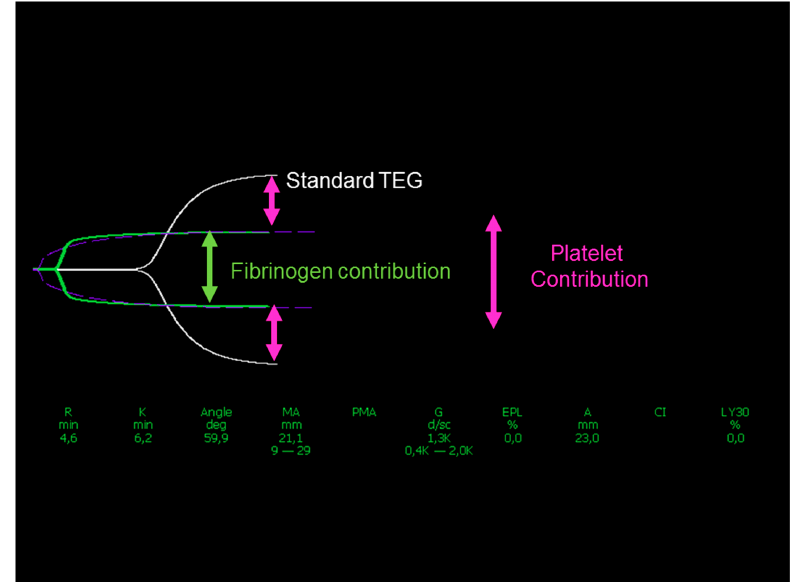
Figure 2. Platelet contribution to clot strength as the difference between amplitudes in standard thromboelastography (TEG, white trace) and fibrinogen contribution (green trace). However, it must be considered that this approach, even if apparently logical, suffers from a certain degree of bias. Shear modulus (or elasticity) is not linearly associated with clot amplitude, being rather defined by the equation [16]: Shear modulus (G, [dyn/cm²] = (5000 × amplitude [mm])/(100 − amplitude [mm])), that is graphically shown in Figure 3.